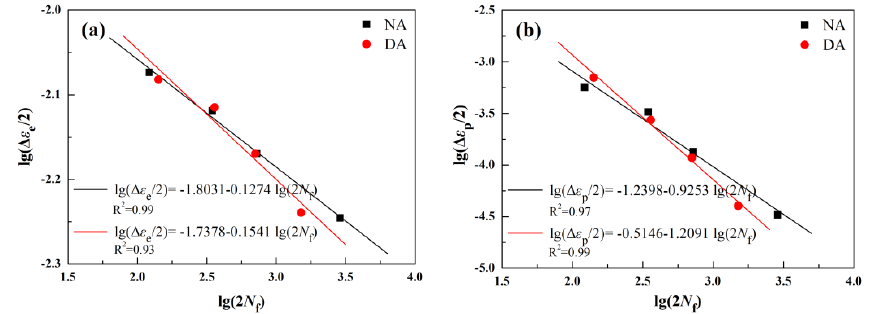
Figure 9. Evaluation of fatigue parameters for the alloy: ( a ) Coffin–Manson plot; and ( b ) Basquin plot.